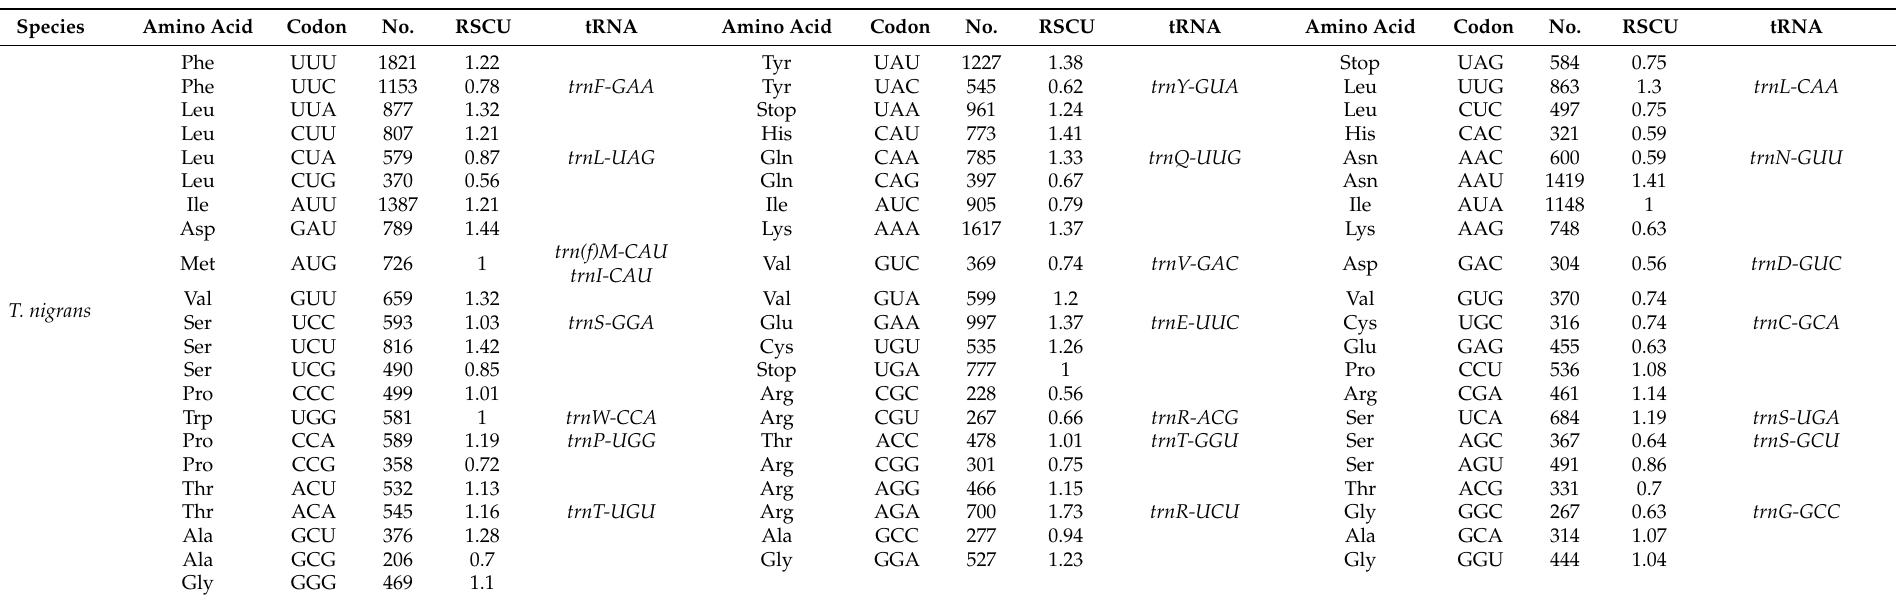
Table 4. Codon–anticodon recognition patterns and codon usage of the T. nigrans and S. parasitica chloroplast